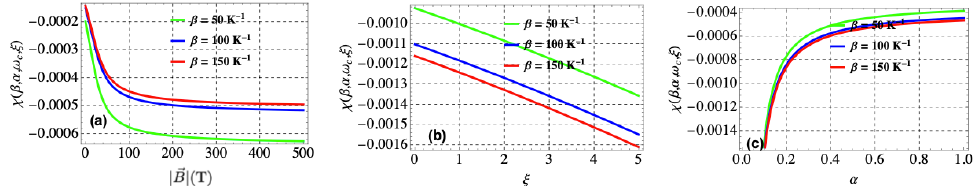
Figure 7. Magnetic susceptibility χ ( β ) as a function of ( a ) | (cid:126) B | ( T ) for different values of β and the same fixed values as in Figure 1a, ( b ) ξ for different values of β and the same fixed values as in Figure 1b, ( c ) α different values of β and the same fixed values as in Figure 1c. For all three plots, β = 50 k − 1 (green curve), 100 k − 1 (blue curve) and 150 k − 1 (red curve); the maximum vibrational quantum n max and other parameters are same as in Figure 1.